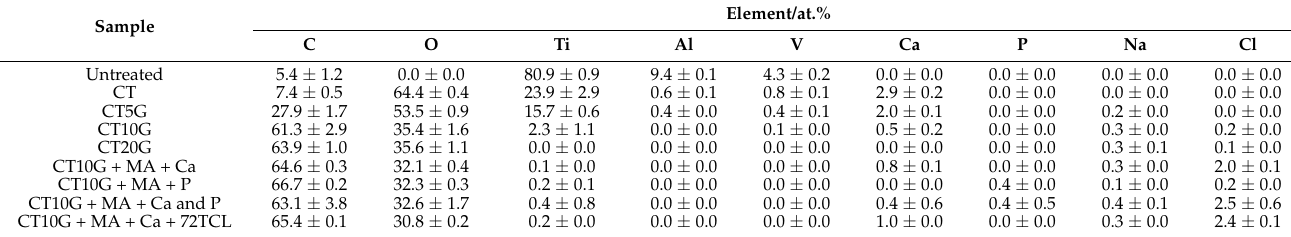
Table 2. EDX results on the Ti–6Al–4V alloy surfaces treated with Ca–heat followed by gelatin coating